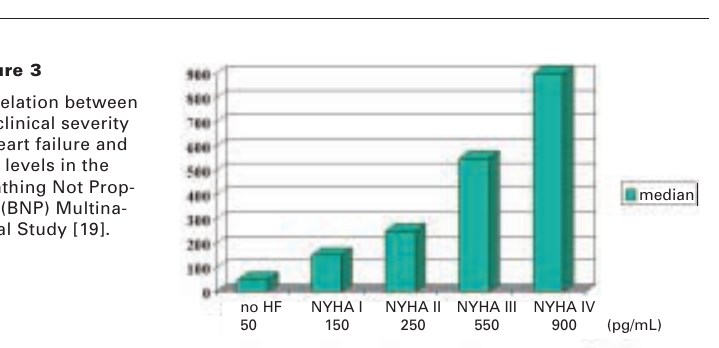
Patients with congestive heart failure (CHF) do have significantly higher BNP levels as compared with patients with dys- pnoea due to chronic obstruc- tive lung disease (COPD) [16].